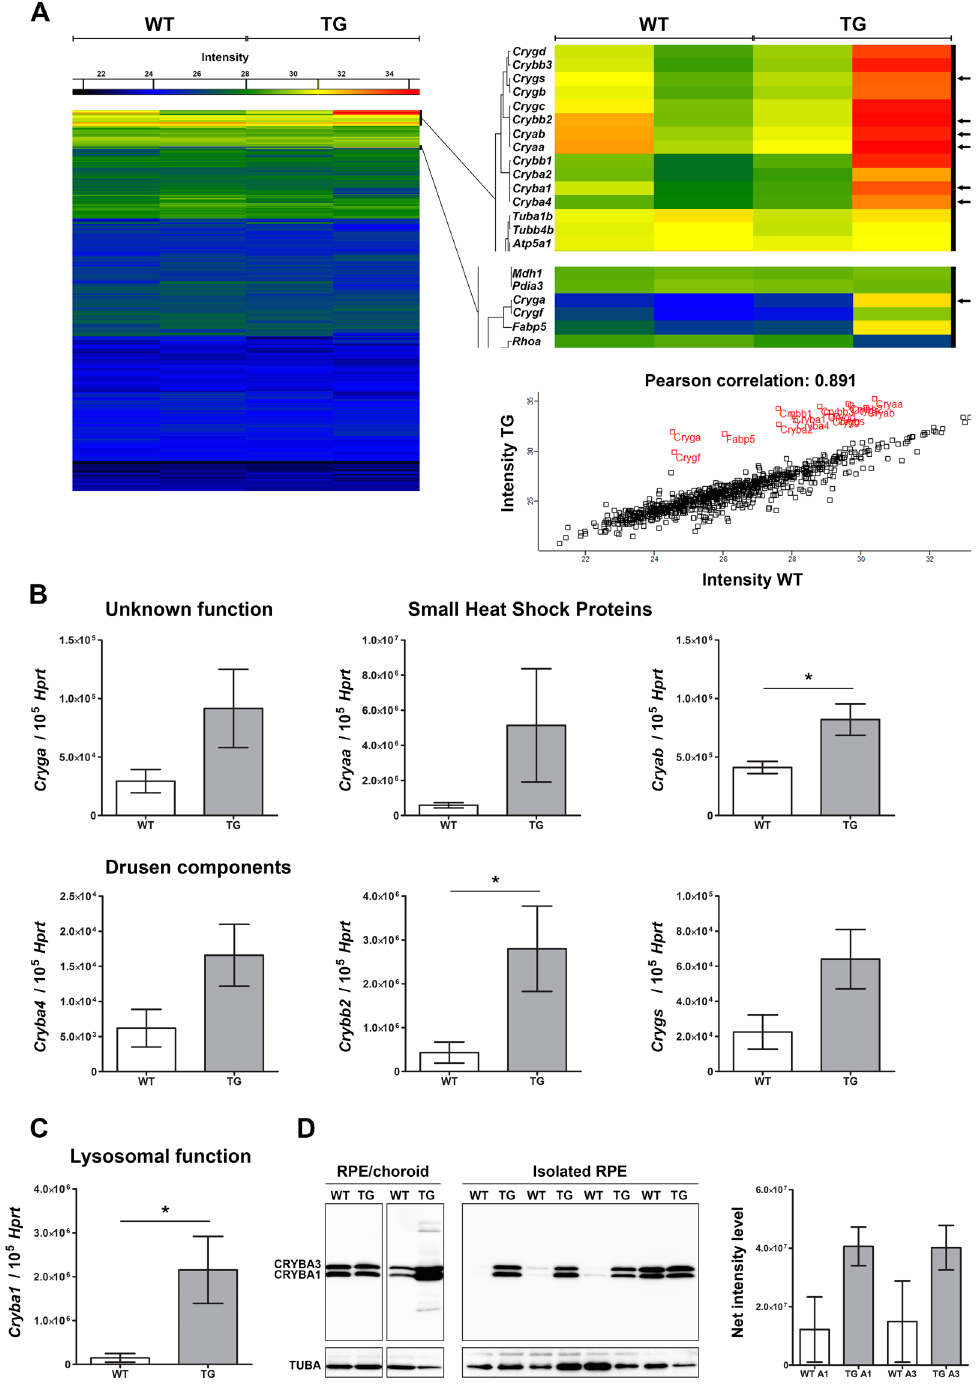
Figure 3. Crystallin genes and proteins are differentially expressed. ( A ) Heatmap showing expression levels of 963 proteins detected in RPE/choroid homogenates from WT (left) and TG (right) mice (2 independent experiments). Eyecup pool WT, n = 4 mice; eyecup pool TG n = 3–4 mice. Zoom showing relative intensities for the crystallin protein cluster. Expression of genes coding for targeted crystallin family members was further evaluated by qRT-PCR (black arrows). Graph showing Pearson correlation (2 independent experiments). ( B ) Histogram showing relative mRNA levels of drusen components ( Cryba4 , Crybb2 and Crygs ), genes coding for small heat shock proteins ( Cryaa and Cryab ) and Cryga in the RPE by qRT-PCR. Each mRNA level was normalized to Hprt . Data represent mean ± SEM; n = 6–10 mice per group. * P ≤ 0.05. ( C ) Histogram showing relative mRNA levels of Cryba1 , involved in lysosomal function, in the RPE by qRT-PCR. Each mRNA level was normalized to Hprt . Data represent mean ± SEM; n = 7–9 mice per group. * P ≤ 0.05. ( D ) Immunoblots of CRYBA1/3 and TUBA using RPE/choroid homogenates analysed by mass spectrometry (left, proteins from 3–4 mice per lane) and isolated RPE protein extracts (right, 1 animal per lane, n = 4 each